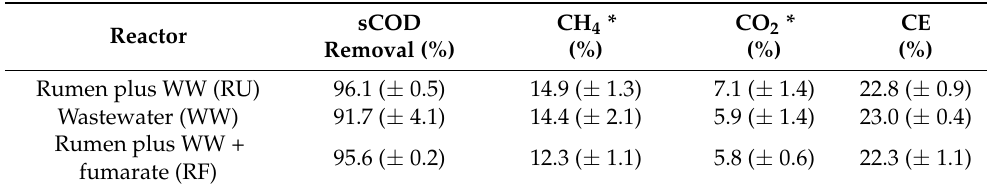
Table 1. Average performance observed during approximately 60 days of operation at pH 7, 30 ◦ C, and across 1 k Ω external